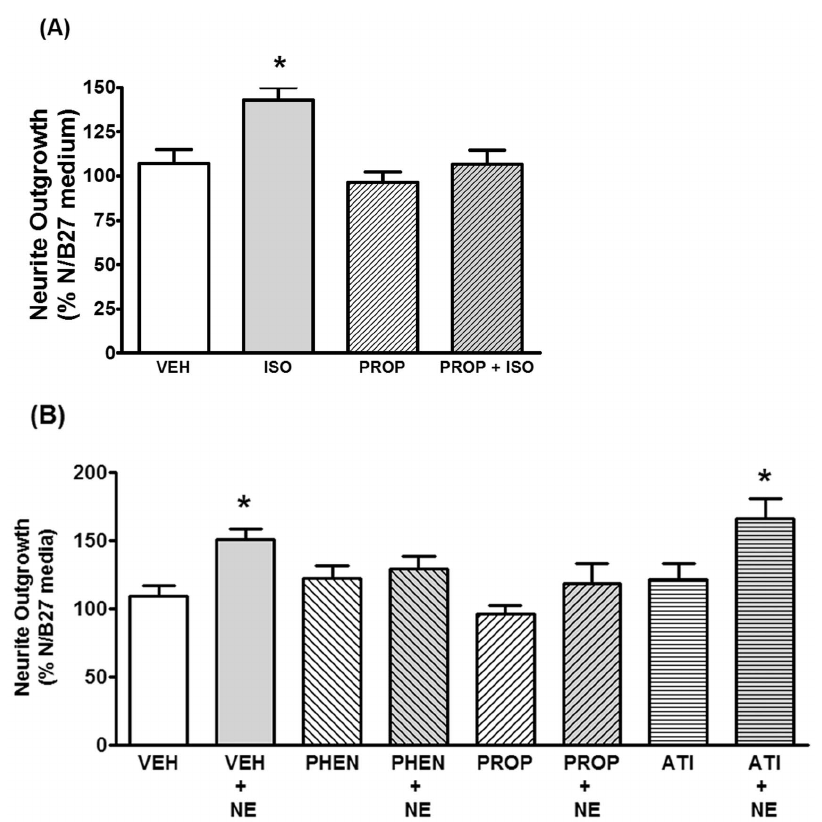
Figure 6. Both alpha- and beta-adrenergic antagonists prevent adrenergic agonists from stimulating astrocytes to produce neurite- promoting factors. (A) Astrocytes were incubated in N/B27 media to which vehicle (VEH), isoproterenol alone (ISO; 1 uM), the beta antagonist propranolol alone (PROP; 1 uM), or isoproterenol plus propranolol (ISO + PROP) were added just prior to 6 hr incubation. Following concentration by ultrafiltration the conditioned media were applied to primary cortical neurons seeded on poly-lysine coverslips in N/B27. Following 24 hr incubation neurons on coverslips were fixed and stained for MAP2 and analyzed for neurite outgrowth as described in Methods. Data were analyzed by one-way ANOVA followed by Bonferroni multiple comparisons of selected groups (i.e. VEH vs VEH + ISO, PROP vs PROP + ISO). Data represent the mean 6 SEM of 5 independent observations. *, P , 0.05 as compared to VEH. (B) Astrocytes were incubated in N/B27 media to which vehicle (VEH) or the indicated drugs were added just prior to 6 hr incubation. VEH=vehicle, NE=norepinephrine (10 uM), PHEN=phentolamine (1 uM), PROP=propranolol (1 uM), ATI=atipamezole (1 uM). Following concentration by ultrafiltration the conditioned media were applied to primary cortical neurons seeded on poly- lysine coverslips in N/B27. Following 24 hr incubation neurons on coverslips were fixed and stained for MAP2 and analyzed for neurite outgrowth as described in Methods. Data were analyzed by one-way ANOVA followed by Bonferroni multiple comparisons of selected groups (i.e. VEH vs VEH + NE, PHEN vs PHEN + NE, PROP vs PROP + NE, ATI vs ATI + NE). Data represent the mean 6 SEM of 5 independent observations. *, P ,